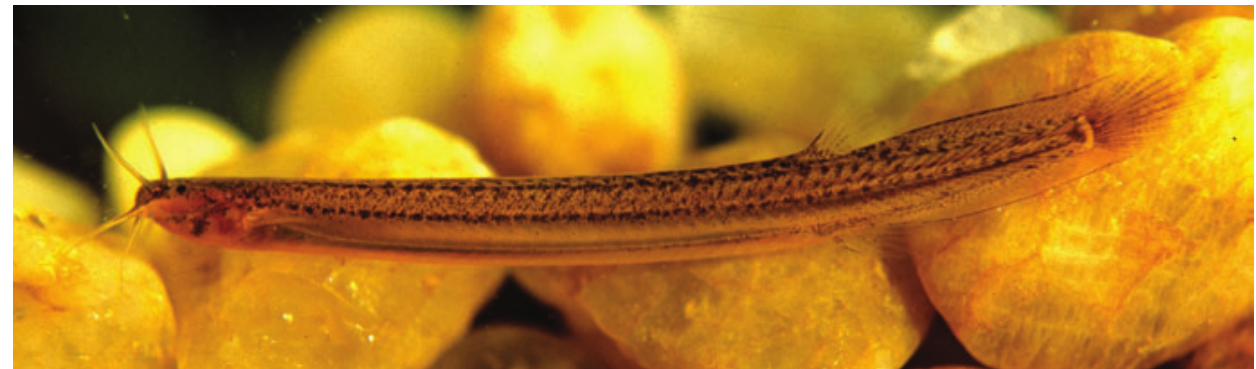
Fig. 1. Listrura costai , new species, holotype, MNRJ 31917, 31.3 mm SL, live specimen photograph; Brazil, Rio de Janeiro State, Angra dos Reis Municipality. Photo by Wilson J. E. M.